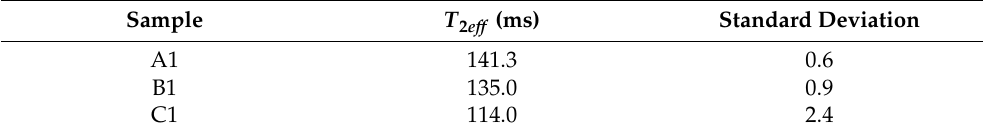
Table 3. T 2eff of the samples. Table 3. T 2 eff of the samples.